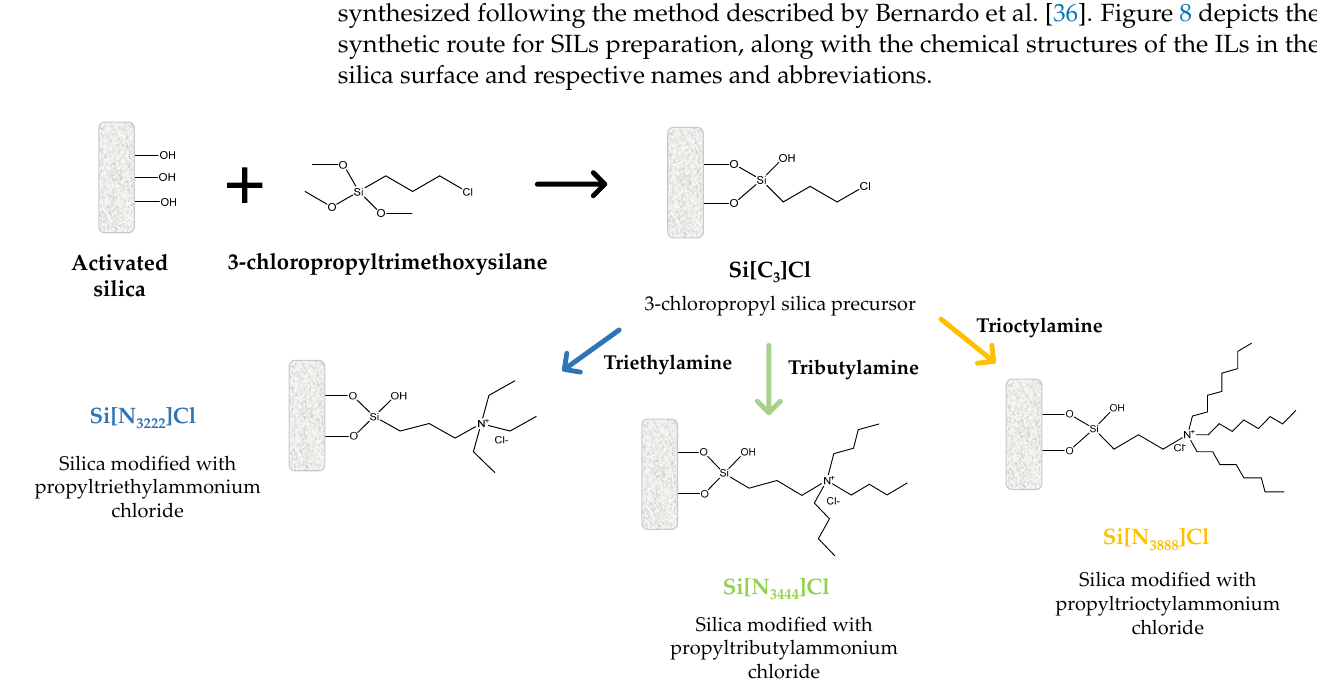
Figure 8. Overview of the synthetic route of SILs, along with the chemical structures of the IL attached to the silica surface and respective names and abbreviations.